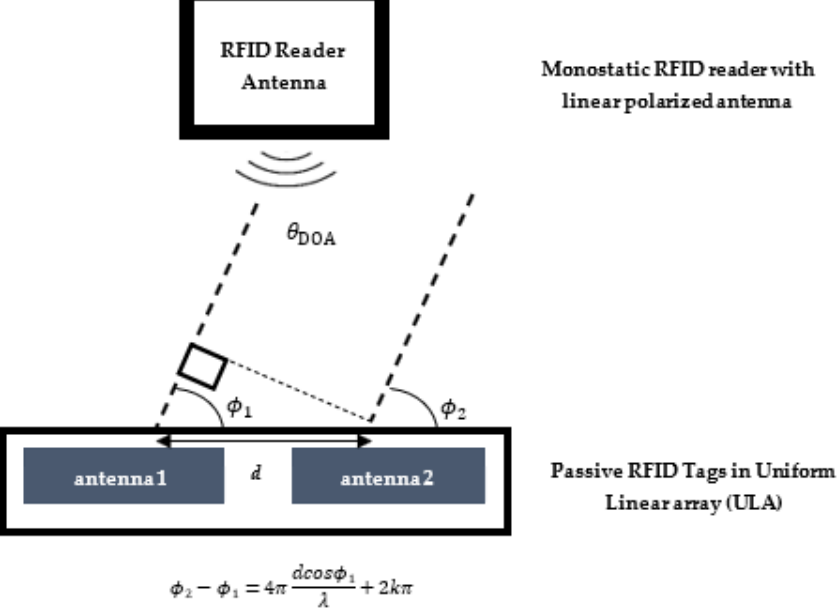
Figure 4. DOA in the spatial domain for two tags and a monostatic antenna.